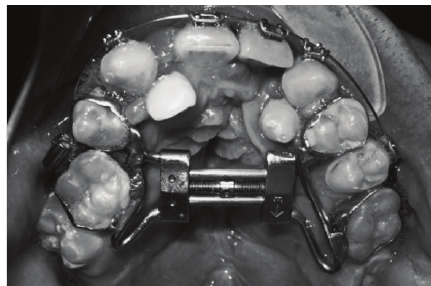
Figure 2: Type hyrax disjunction device. Intraoral image of dis- junctor. You can observe that the exodontia of 1.5 has already been performed, but not the others yet (lateral incisor 1.2 and supernumerary teeth). Behind the device you can see the mucous scar of the